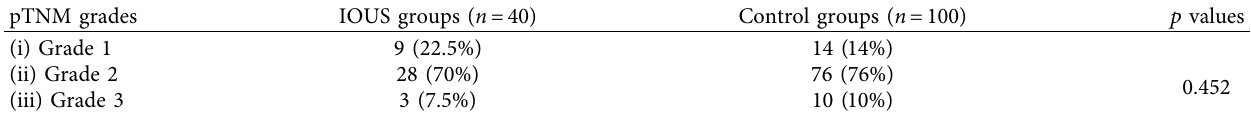
Table 4: Tumor grade in the two study groups.